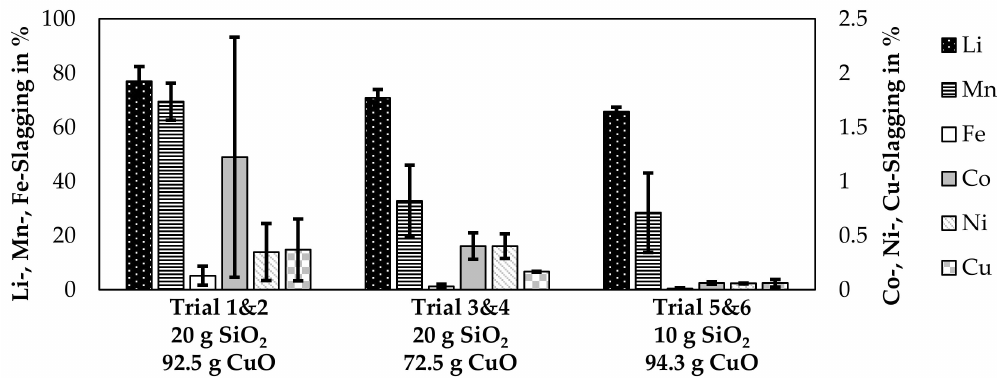
Figure 9. Slagging of metals observed in the laboratory-scale trials. Oxide addition in g per 100 g black